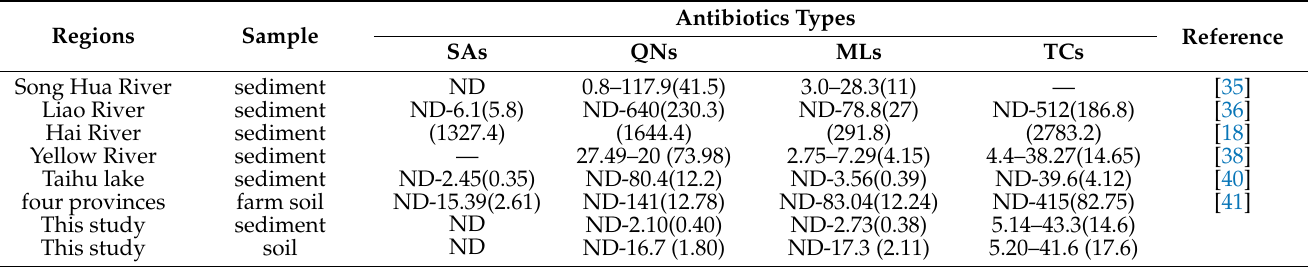
Antibiotics Types